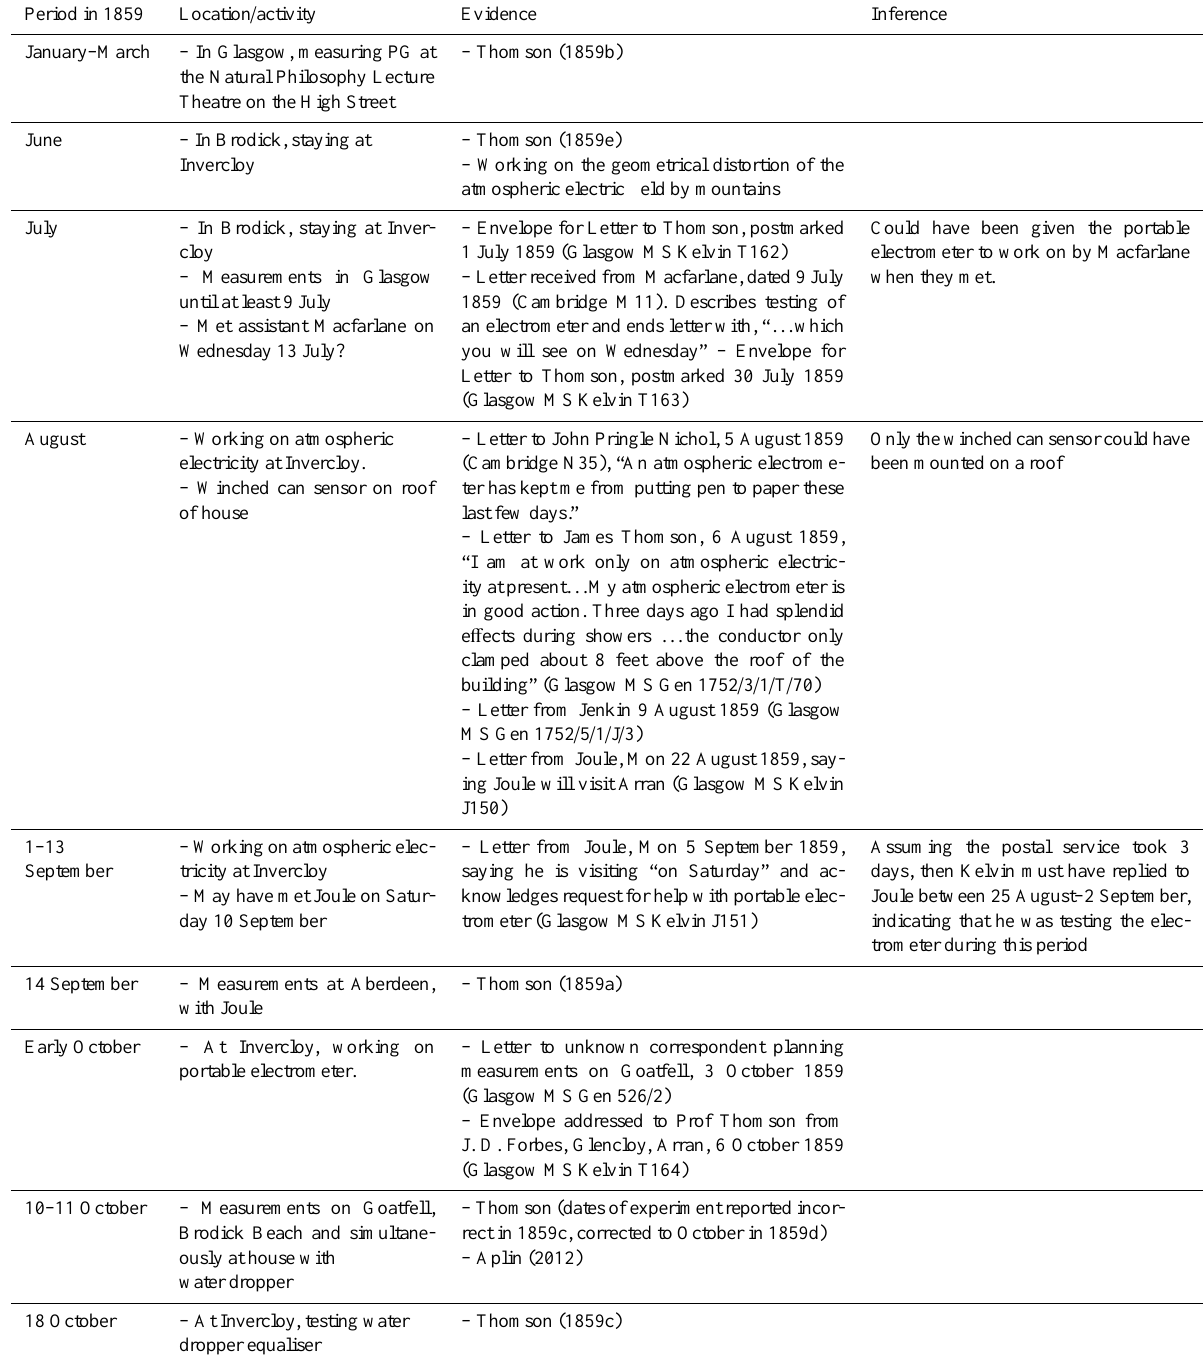
Table 1. Kelvin’s 1859 Scottish PG measurements. Letter references refer to the local classification at the library where the letter is held (Cambridge or Glasgow University